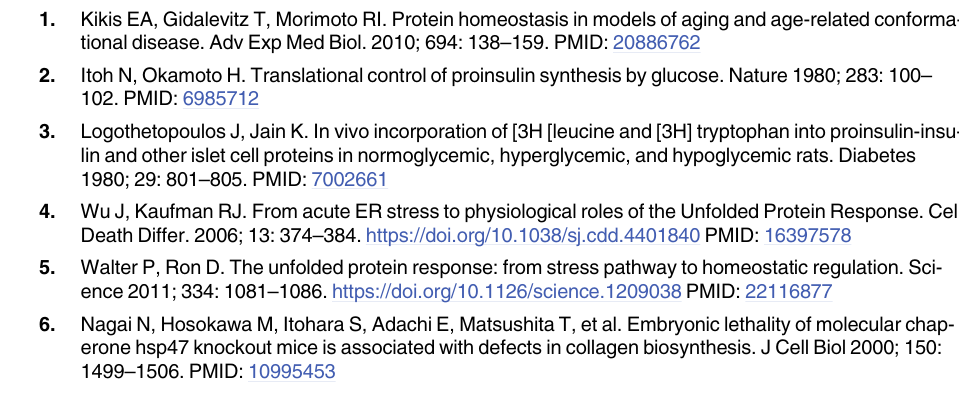
elements (right panel) is still specifically induced in the differentiating alae-secreting cells. (C) Screenshot of the WormBase GBrowse image of BLMP-1 binding peak in hsp-4 promoter, lum; GFP, green fluorescent protein; HSP-4, Heat-Shock Protein 4. S5 Fig. BLMP-1 represses both BiP isoforms but not other UPR targets. (A) Down-regula- tion of blmp-1 results in mild induction of hsp-3 expression in seam cells but not hypodermis of late L2d animals. RNAi and scoring as in Fig 3, the expression classes scored were induction in all seam cells (indicated as s.c.), induction in one or more but not in all seam cells (few s.c.), or no induction. (B) Down-regulation of blmp-1 did not result in induction in seam cells of two additional UPR target genes, enpl-1 and cnx-1 , coding for C . elegans orthologues of GRP94 and calnexin, respectively. BiP, immunoglobulin heavy chain-binding protein; BLMP-1, a C . elegans orthologue of B-Lymphocyte-Induced Maturation Protein 1 BLIMP1; GRP94, Glucose Regulated Protein, 94 kDa; hsp-3 , heat shock protein 3; L2, second larval stage; L2d, predauer L2; RNAi, RNA interference; UPR, unfolded protein